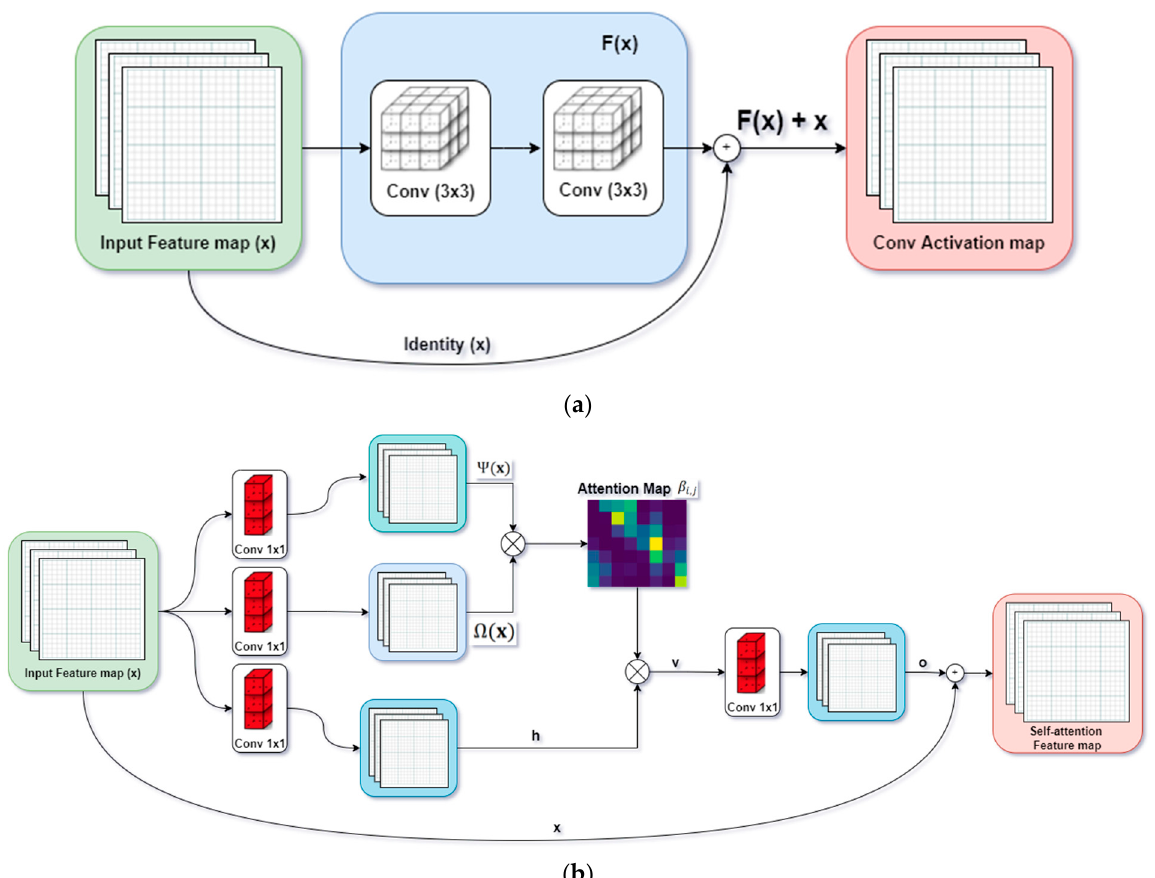
Figure 3. Proposed ResNet-Self Attention model: The Residual Block is replaced with Self-Attention Module. ( a ) Residual Block implemented with identity mapping by shortcut in [12]; ( b ) Self-Attention Module proposed in [15].